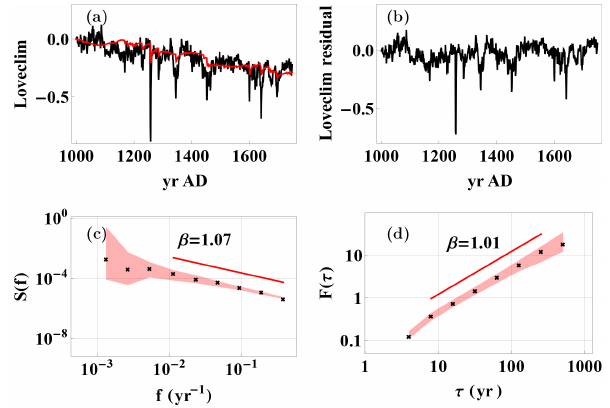
Figure 6. (a) The temperature from the COSMOS experiment. (b) PSD, (c) DFA2, and (d) WVA2 applied to the record. The shaded areas are the 95% confidence range for synthetic fGn with β esti- mated by PSD, DFA2 and WVA2. The β -values are estimated from the slopes of the straight lines and the range of scales used for es- timation is indicated by the length and position of these line seg- ments. The estimated β -values are indicated in the